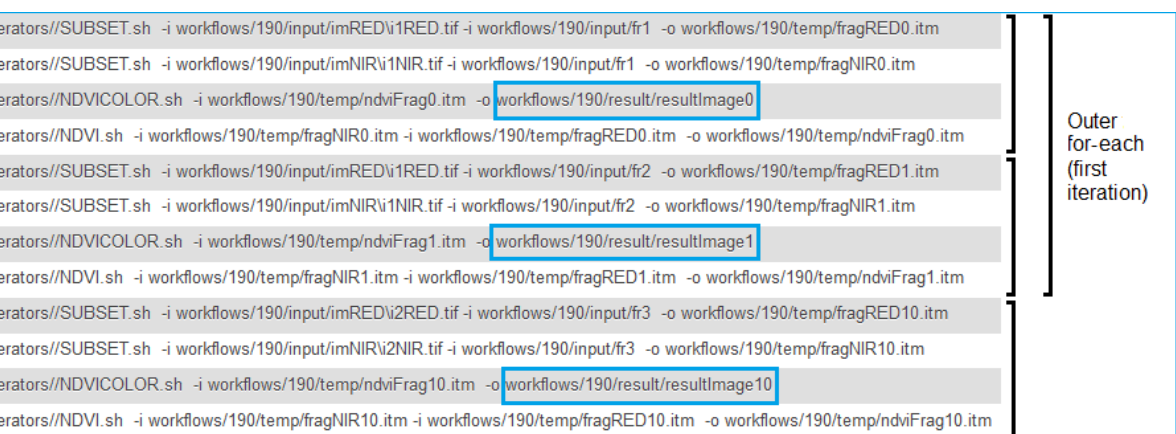
Figure 7. Double for-each scheduling